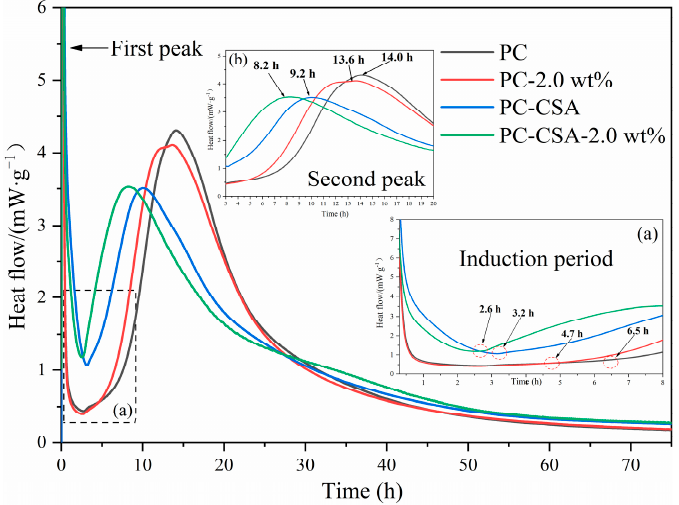
Figure 6. Hydration heat flow of different binders. ( a ) Second peaks, ( b ) induction period.